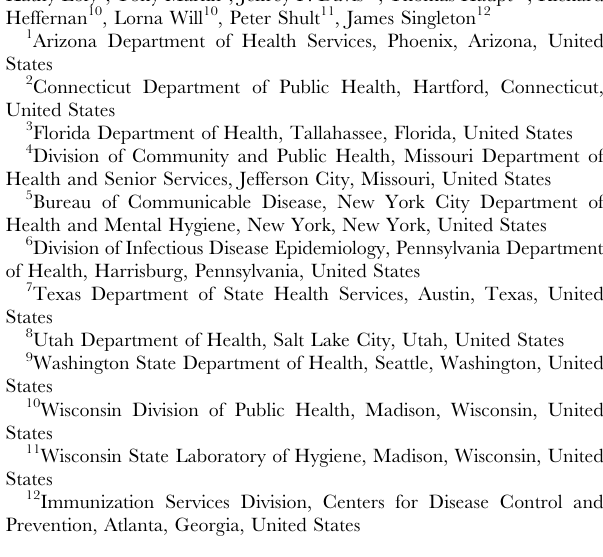
Figure S1 Site–specific trends in influenza–like illness (ILI), with period of sera collection. a Source: U.S. Outpatient Influenza-like Illness Surveillance Network